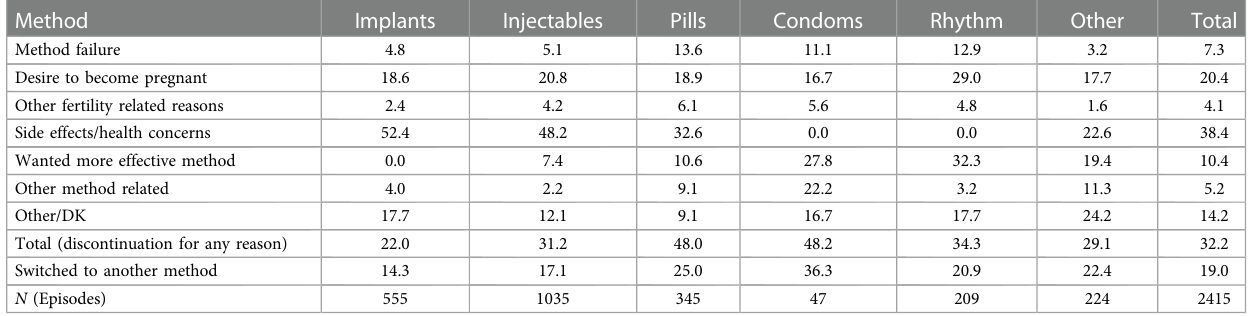
TABLE 3 Percent distribution of discontinuations of contraceptive methods in the 12 months preceding the survey by main reason stated for discontinuation, according to speci fi c method, Nairobi, Kenya